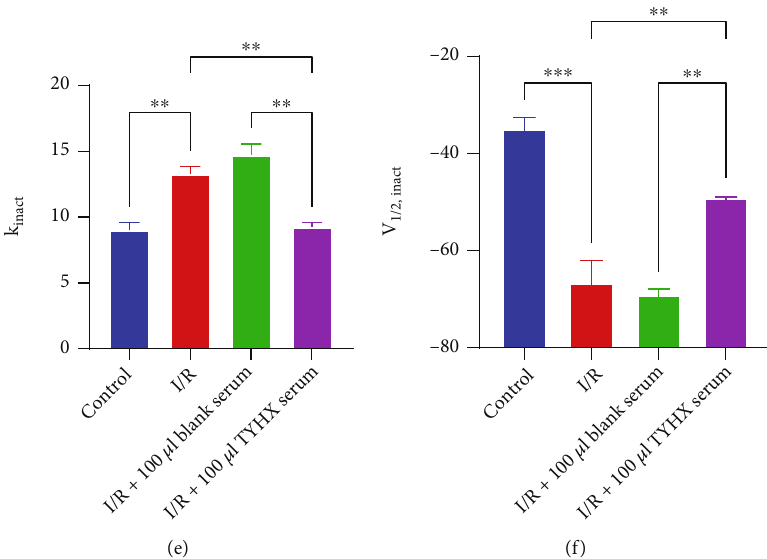
Figure 7: The e ff ect of TYHX on steady-state activation and inactivation of I (b) V 1/2,act of SSA. (c) k value of SSA. (d) The e ff ect of TYHX on steady-state inactivation of I ∗ p < 0 : 05 , ∗∗ p < 0 : 01 , and ∗∗∗ p < 0 : 001